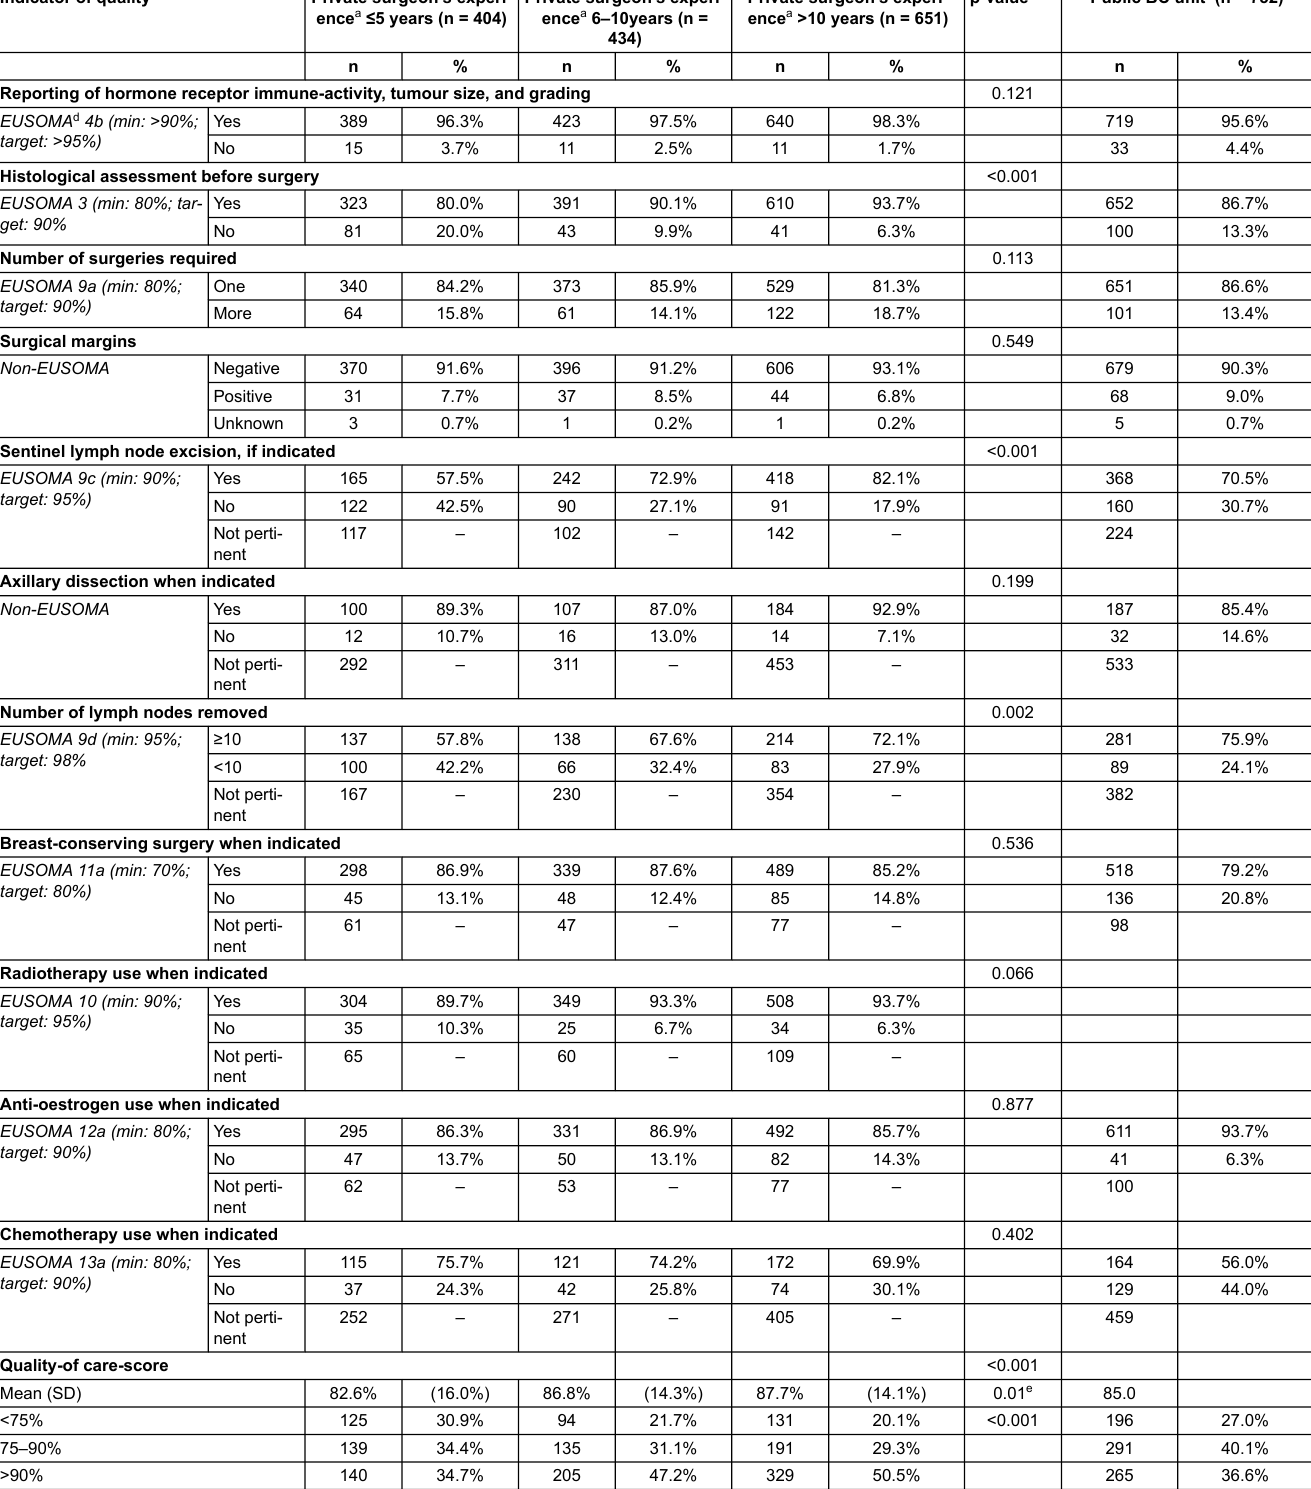
Table 3: Quality of diagnosis assessment and treatment according to the surgeon's experience (Geneva Cancer Registry, 2000–2009). Indicator of